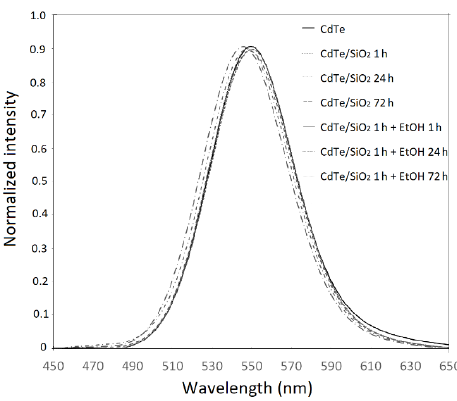
Figure 1. The emission spectra of as-synthesized CdTe quantum dots(QDs) and the silanized aliquots of CdTe QDs with and without presence of ethanol in specific times (1, 24, and 72 h).